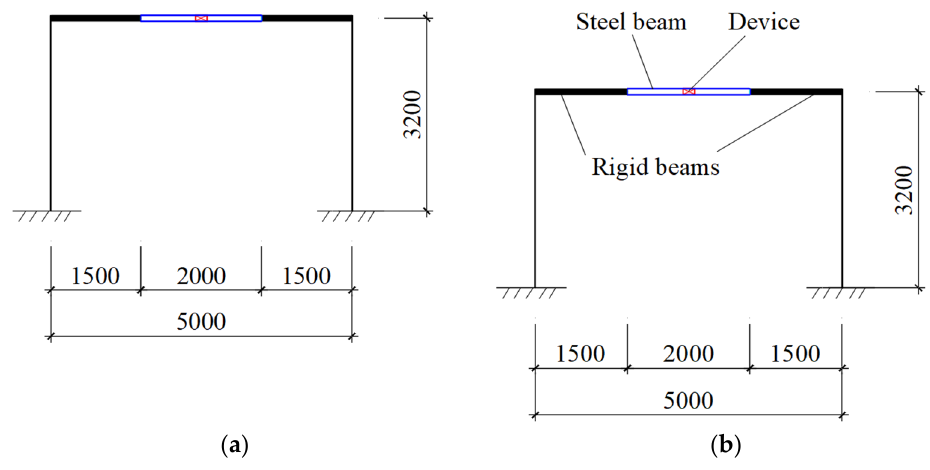
Figure 12. One-storey frame: ( a ) Details of frame; ( b ) Frame model using SAP2000.